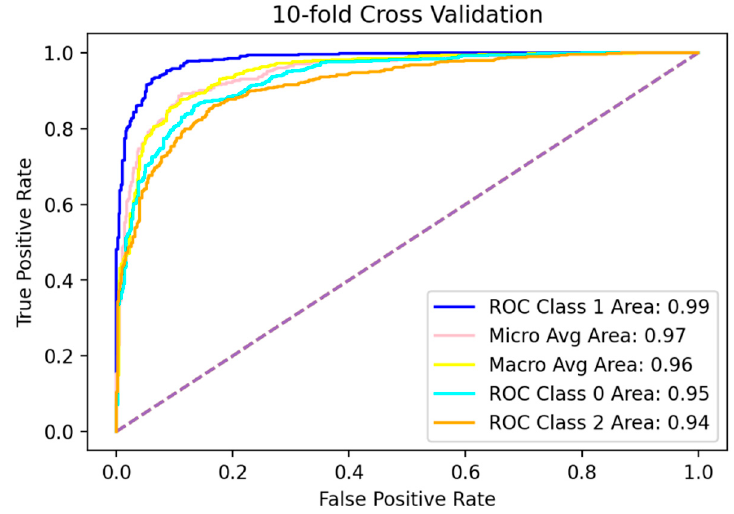
Figure 4. Mean ROC of 10-fold cross-validation.